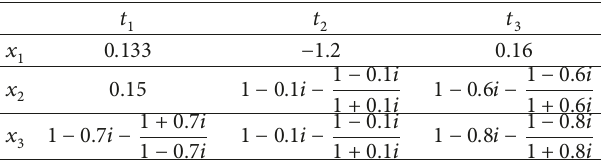
Table 14: The hesitation degree of a TCIFS A